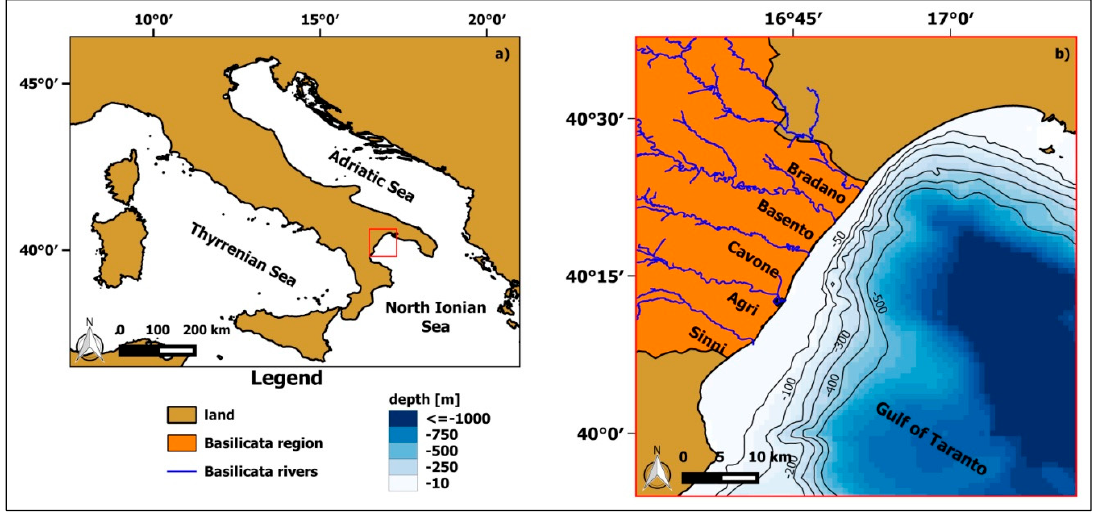
Figure 1. ( a ) BICW localization (red box) in the Mediterranean Sea; ( b ) magnification of the study area within the red box of (a) where the Basilicata region is depicted in orange. The main rivers of the region (blue lines) and the bathymetry from 50 to 500 m (in blue tones and with the black contour lines) are also reported.